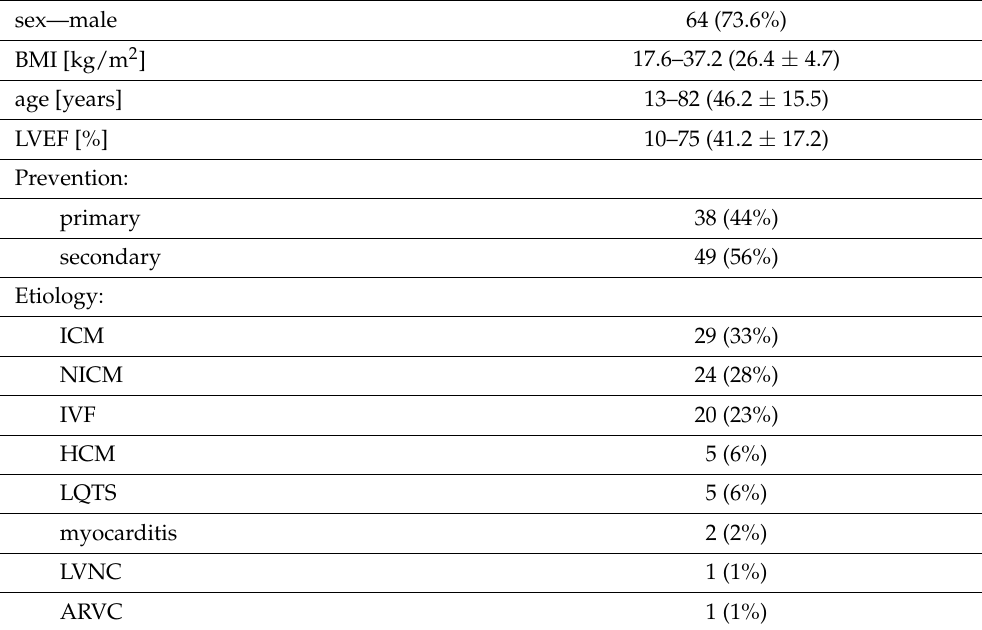
Table 1. Demographic and clinical data of patients included in the study group.